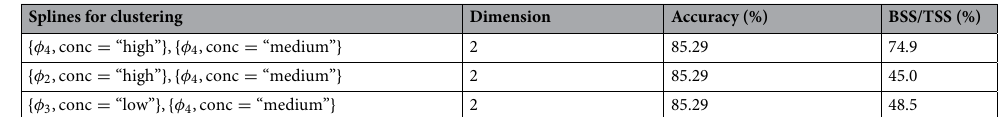
Splines for clustering